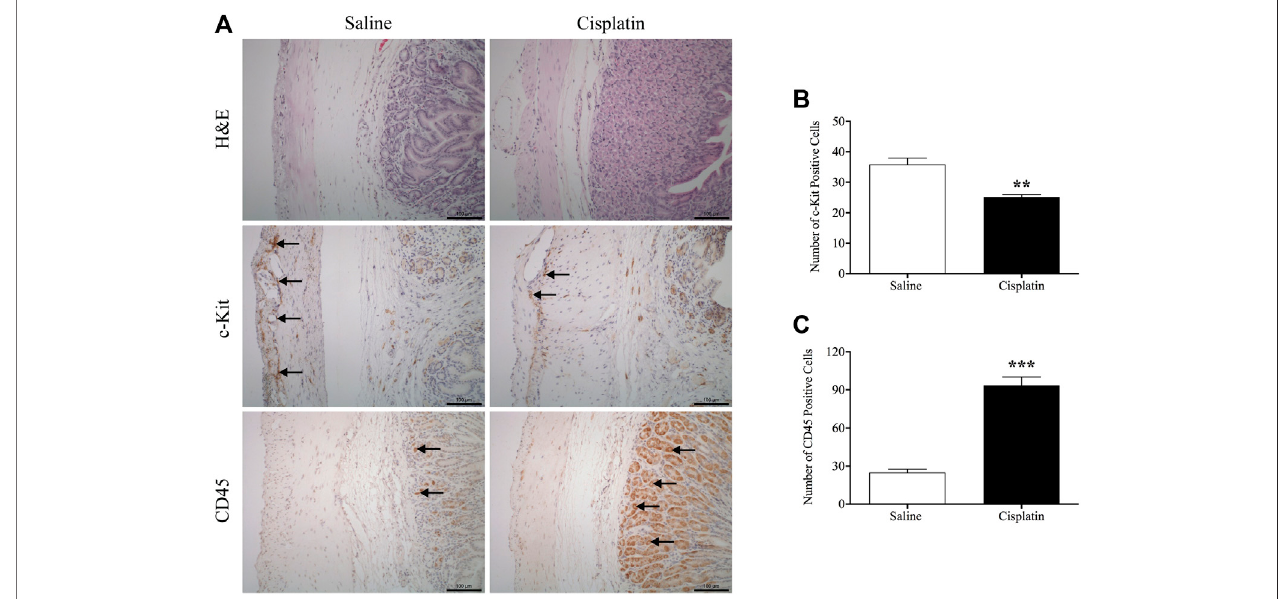
FIGURE 8 | Effects of cisplatin (30 mg/kg, intraperitoneal) on morphology and associated protein expression in the antrum region of the stomach in Suncus murinus . (A) Representative images of haematoxylin and eosin staining, and immunohistochemistry images of c-kit and CD45; (B) changes in the number of c-kit- positive cells; (C) changes in the number of CD45-positive cells. Signi fi cant differences between cisplatin and saline groups are shown as ** p < 0.01 or *** p < 0.001 (Student ’ s t -test). The results are presented as means ± standard errors of the mean for n (cid:1) 7 – 8 animals. Positive cells are indicated by black arrows. Scale bar: 100 μ